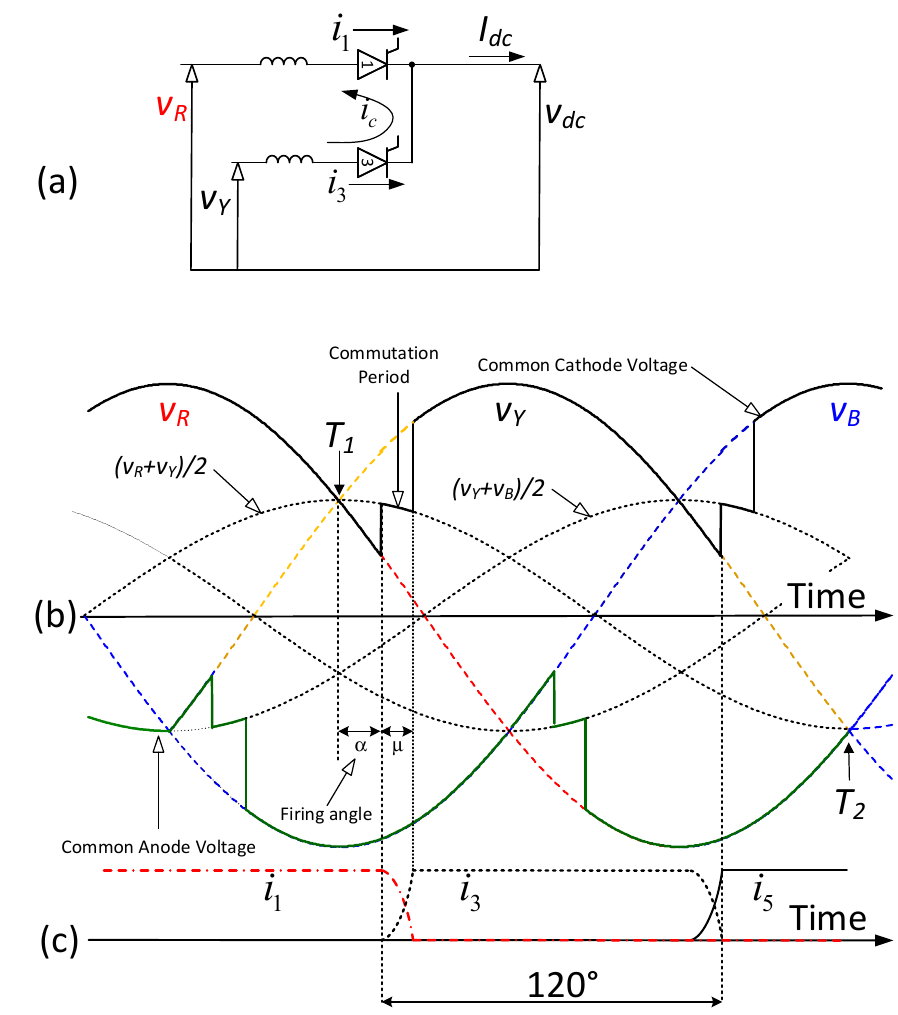
Figure 13. The commutation process in a 6-pulse bridge ( a ) Equivalent circuit for commutation between thyristor 1 and 3 ( b ) Voltage waveforms (rectification) ( c ) the current waveforms.